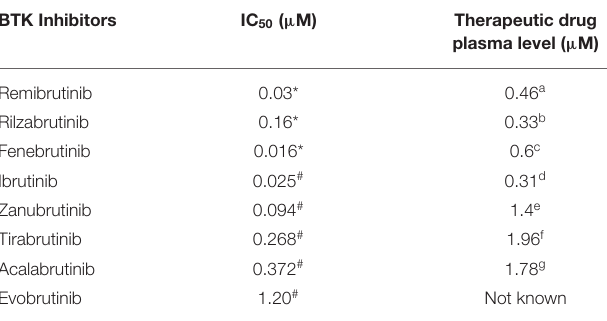
TABLE 1 | IC 50 values of remibrutinib, rilzabrutinib and other BTK inhibitors for inhibition of low degree GPVI stimulated platelet aggregation, and comparison with therapeutic drug plasma